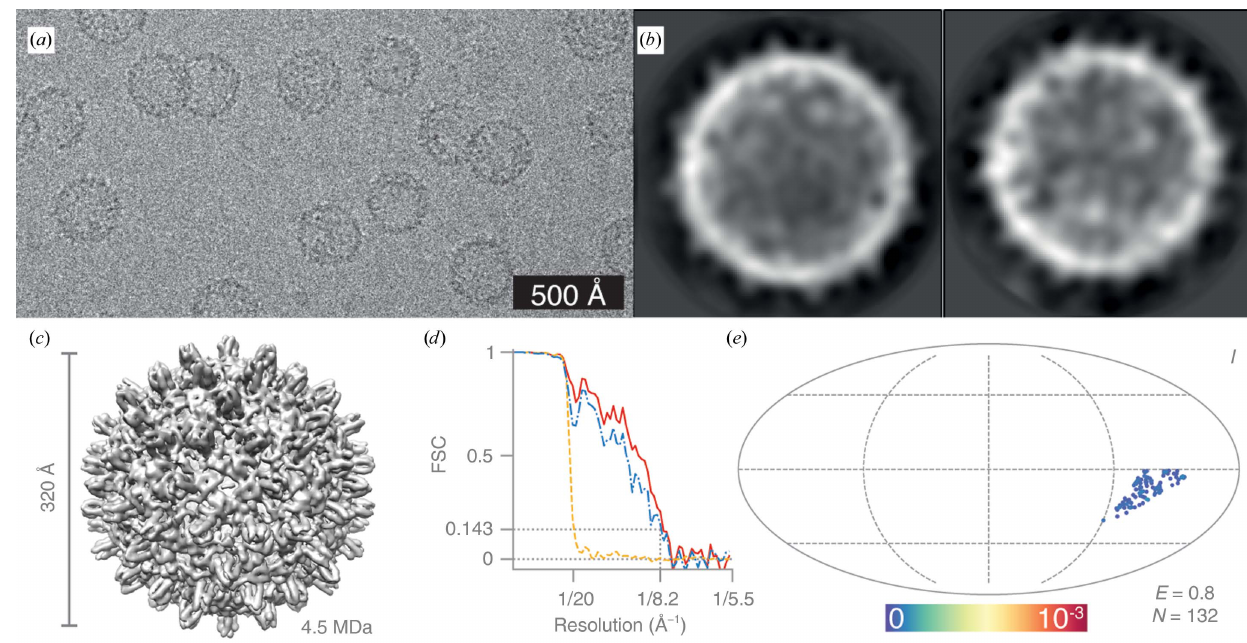
Figure 9 Structure of hepatitis B virus capsid determined at 100 keV. ( a ) Typical micrograph after motion correction. Contrast is adjusted to (cid:8) 3 (cid:3) from the mean intensity. ( b ) 2D class averages. ( c ) Sharpened masked 3D reconstruction of hepatitis B virus capsid from N = 132 particles with icosahedral ( I ) symmetry. ( d ) Gold-standard FSC plot corresponding to the calculated map, showing the correlation between the phase-randomized (yellow), unmasked (blue) and masked (red) half-maps. The plot terminates at the Nyquist frequency. ( e ) Orientation distribution of the hepatitis B capsids contributing to the final reconstruction (Mollweide projection). All Euler angles are assigned within one asymmetric subunit for the icosahedrally ( I ) symmetric particle. The colour scale (linear) corresponds to the normalized density of views (blue, low; red, high). E = 0.8 is the efficiency of the orientation distribution, indicating nearly uniform sampling of the particle